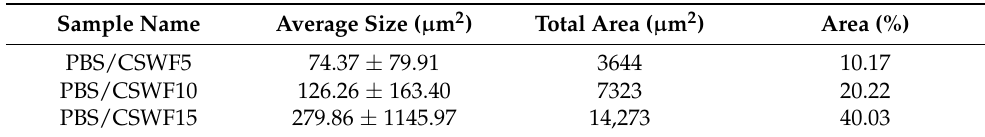
Table 2. Summary results from ImageJ analysis.